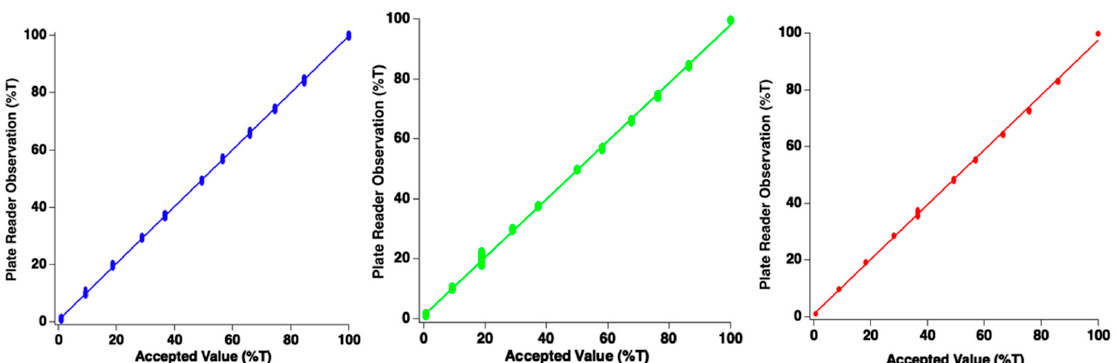
Figure 4. Plots of plate reader photodiode linear response for blue, green, and red channels. Each data point represents a single channel/sensor. It should be noted that ellipses viewed are each clusters of 96 individual data points. Accepted value of illumination intensity was obtained with commercially available spectrometer.